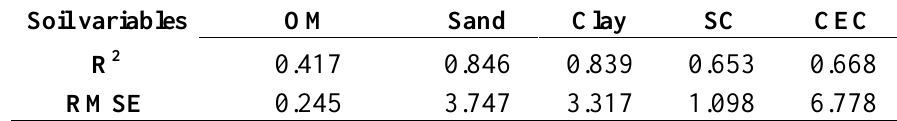
Table 5. Validation results of attributes evaluated in soils by multiple linear regression equations.